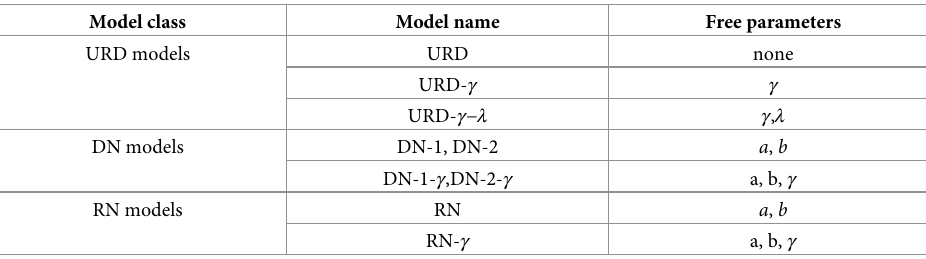
Table 1. Models and their free